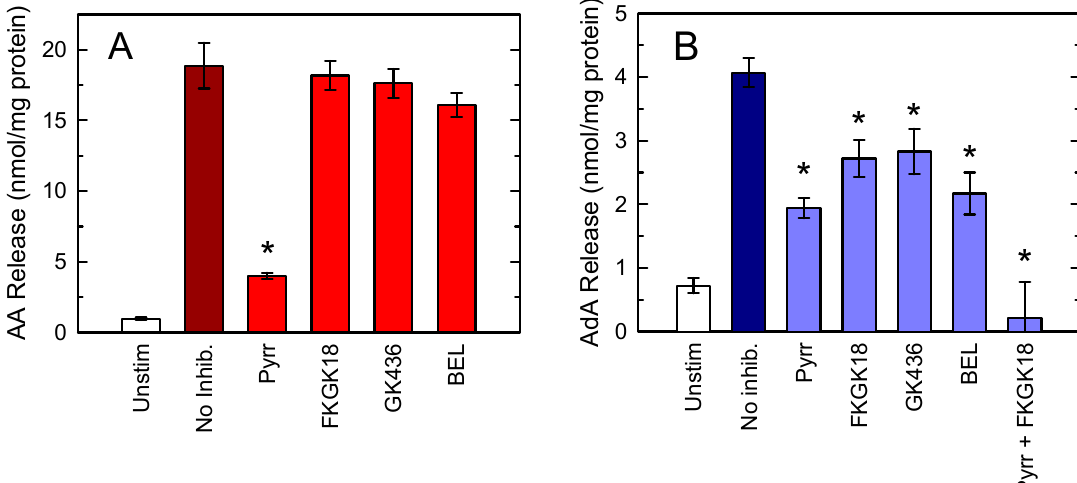
Figure 4. Release of AA and AdA by stimulated macrophages. The cells were either unstimulated (open bars) or stimulated by 1 mg/mL zymosan for 1 h (colored bars) in the absence (no inhibition) or presence of the following inhibitors: 2 µM pyrrophenone (Pyrr), 10 µM FKGK18, 5 µM GK436, 10 µM BEL, or 2 µM pyrrophenone plus 10 µM FKGK18 (see x -axis). Afterward, total content of AA ( A ) or AdA ( B ) was measured by GC/MS. The fatty acid release was calculated by subtracting the amount of phospholipid-bound AA or AdA in stimulated cells from that in unstimulated cells. Results are shown as mean values ± standard error of the mean. (n = 3). Note: * p < 0.05, significantly different from zymosan-stimulated cells in the absence of inhibitors.